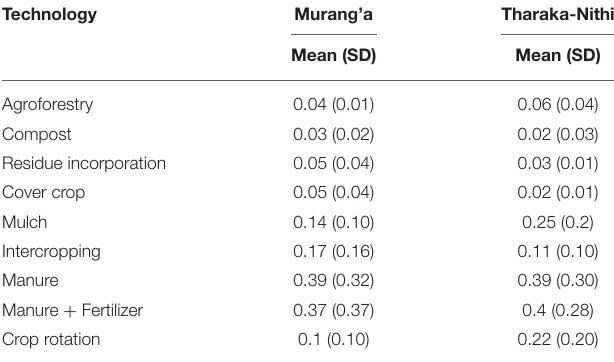
TABLE 5 | Average area (ha) under organic-based technologies in the Central Highlands of Kenya. Technology